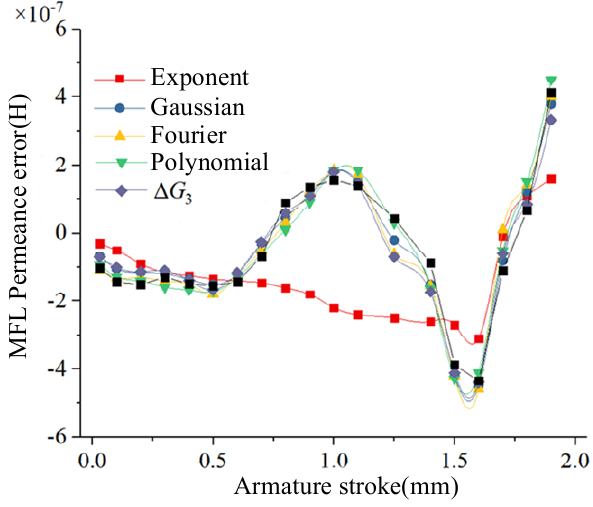
Figure 4. The comparison of ΔG3 calculations and FEM data on basis functions.